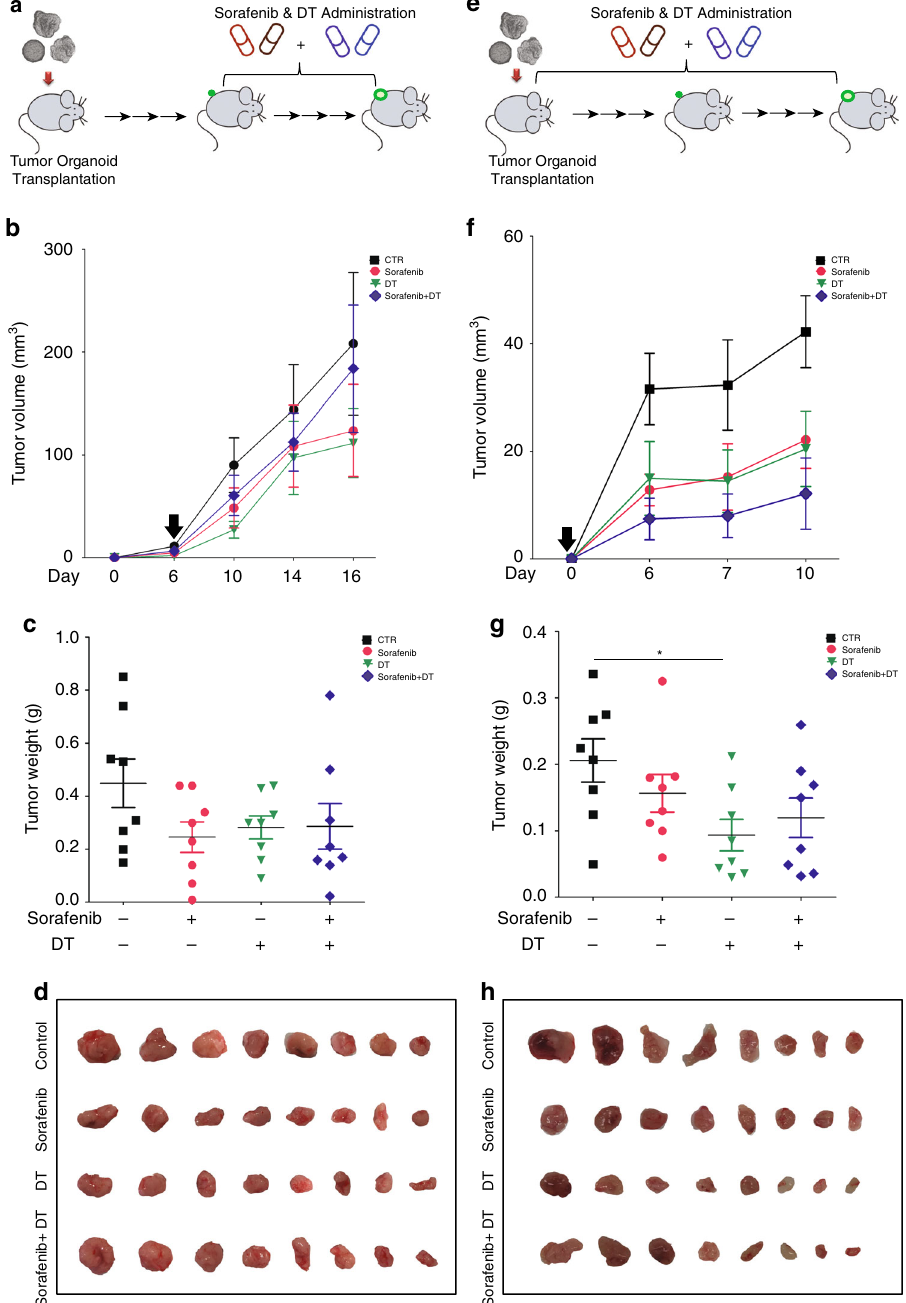
Fig. 7 Combination of LGR5 lineage ablation with sorafenib does not enhance the ef fi cacy. a Outline of the experimental strategy to assess the combinatory effect of LGR5 lineage ablation with sorafenib. Sorafenib and DT were administered every other day for in total 10 days since visualization of tumor formation after organoid engraftment. b Representative growth curves showing tumor volumes in the vehicle control (CTR), sorafenib, DT, and sorafenib + DT-treated groups. Black arrow: onset of administration. c Tumor masses from these four groups (CTR vs. sorafenib vs. DT. vs. sorafenib + DT: 0.45 ± 0.09 g, n = 8 vs. 0.25 ± 0.06 g, n = 8 vs. 0.28 ± 0.043 g, n = 8 vs. 0.29± 0.09, n = 8). d Images showing tumors from these four groups. e Outlines of the experimental strategy for assessing the effects of combining LGR5 lineage ablation and sorafenib treatment. Sorafenib, DT, or the combination were administered immediately since transplantation of the organoids every other day, for in total 10 days. f Representative growth curves showing tumor volumes of the four groups. Black arrow: onset of administration. g The tumor masses of these four groups (CTR vs. sorafenib vs. DT vs. sorafenib + DT: 0.21 ± 0.03 g, n = 8 vs. 0.16 ± 0.03 g, n = 8 vs. 0.09 ± 0.02 g, n = 8 vs. 0.12 ± 0.03 g, n = 8). h Images showing the tumors from the different groups. Mean ± SEM. Source data are provided as a Source Data fi